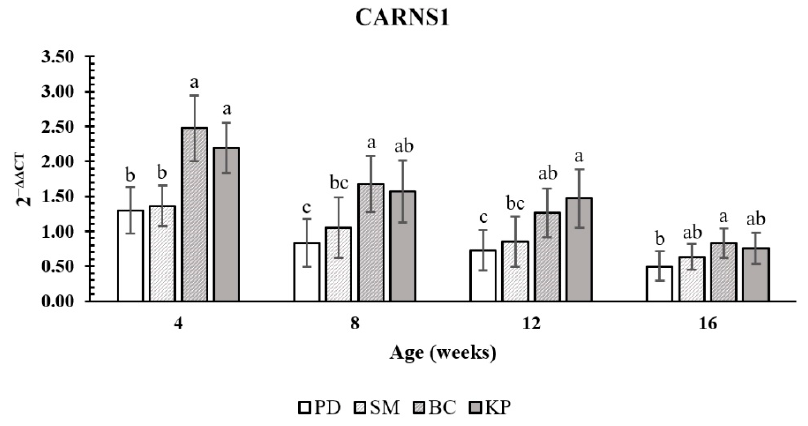
Figure 3. Gene expression level of CARNS1 in breast meat from Pradu Hang Dam (PD), Sri Mok (SM), Black-Chinese (BC), and KU-Phuparn breeds (KP). a,b,c Means within a column lacking a common superscript differ ( p < 0.01).